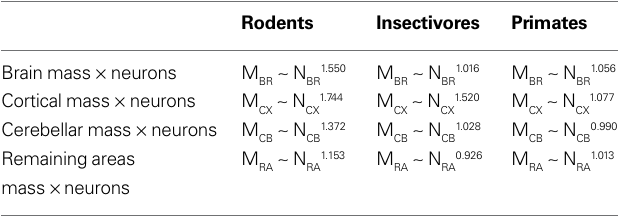
Table 1 | Power law exponents that apply to the scaling of brain mass, or structure mass, as a function of the number of neurons they contain in rodents, insectivores and primates.